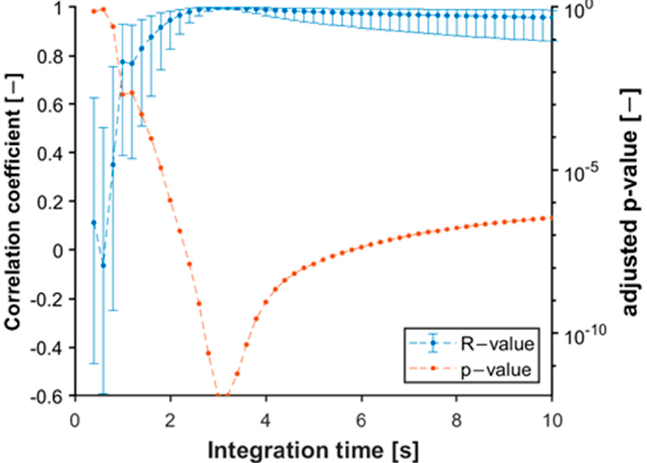
Figure 12. The changing of the correlation coefficients and their 95% confidence interval between the pressure integral and mass based on integration time and the adjusted probabilities for each correlation (cavity 08).